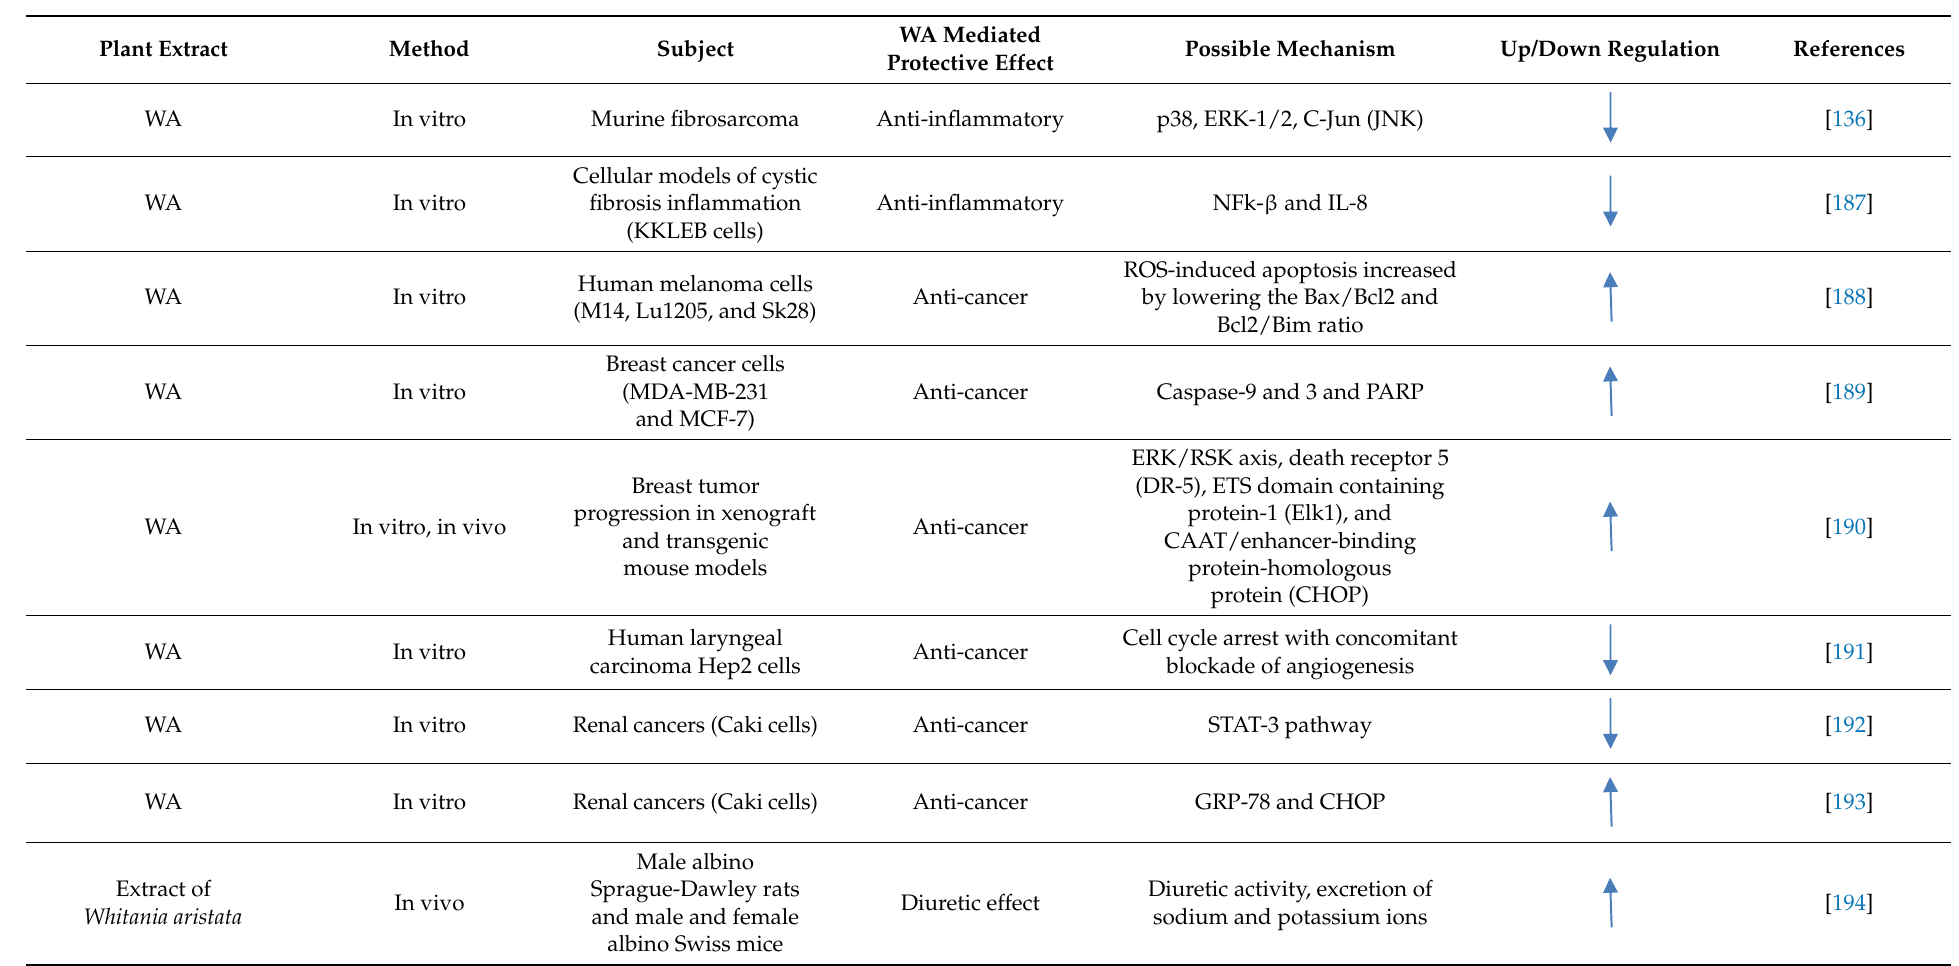
Table 1. Preclinical trials of WA. Table 1. Cont.